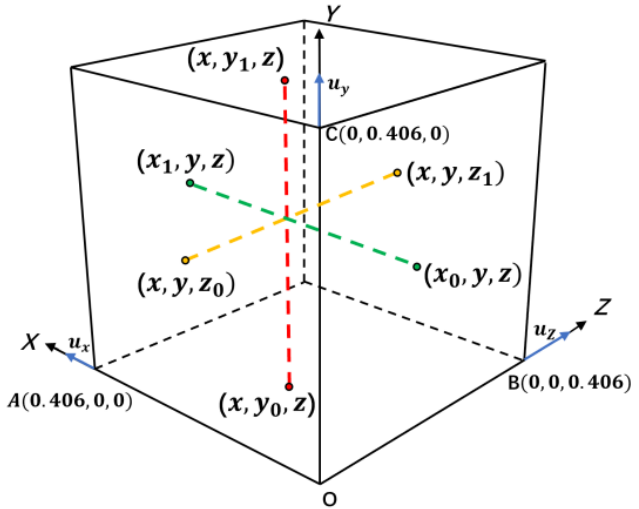
Figure 7. Illustration of the periodic boundary condition.(The dashed lines represent the mutual constraint relationship between two corresponding nodes on two corresponding surfaces.)